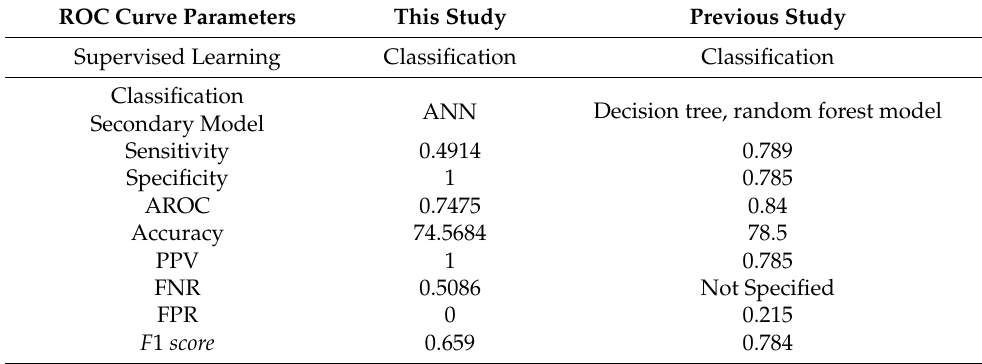
Table 4. Performance metric comparison from literature (ANN) perspective. ROC Curve